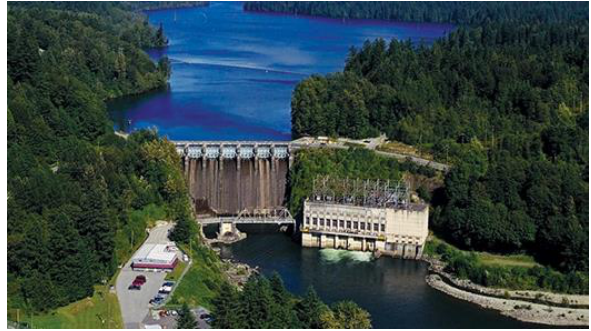
Figure 4. Ruskin Hydroelectric Plant (BCHydro,